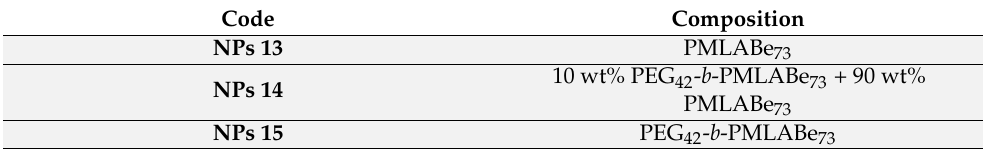
Table 2. Composition of NPs without